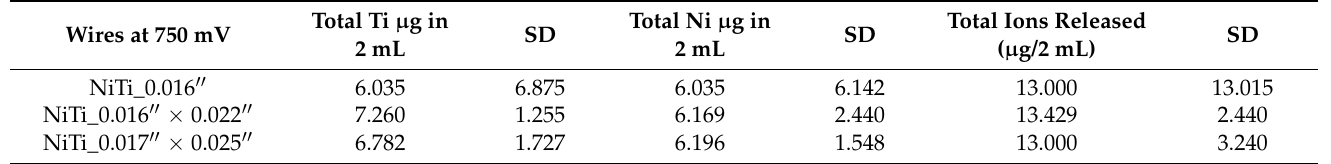
Table 8. The average expected ion release from the NiTi wires at 750